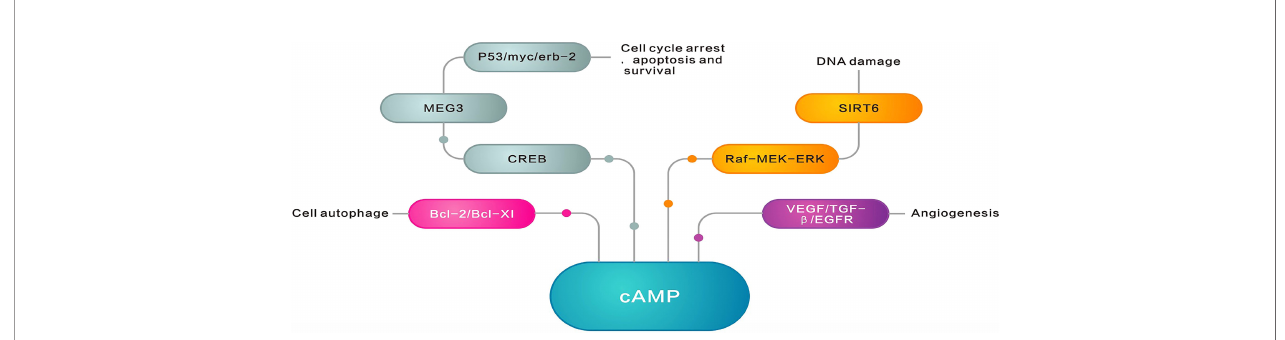
FIGURE 5 | ADCY family roles in cancer recurrence and prognosis. cAMP inhibits cancer formation by blocking extracellular signal-regulated kinase (ERK), inhibiting the antiapoptotic proteins Bcl2 and Bcl-XI, upregulating the cancer suppressor gene p53, inhibiting the oncogenes c-myc and erbB-2, and inhibiting the regulation of the angiogenic pathway by VEGF, TGF- b , and EGFR. However, many cancers exhibit lower AC levels and lower cAMP levels, promoting cancer formation as well as cancer cell proliferation, reducing apoptosis, and even promoting neovascularization, cancer cell migration,